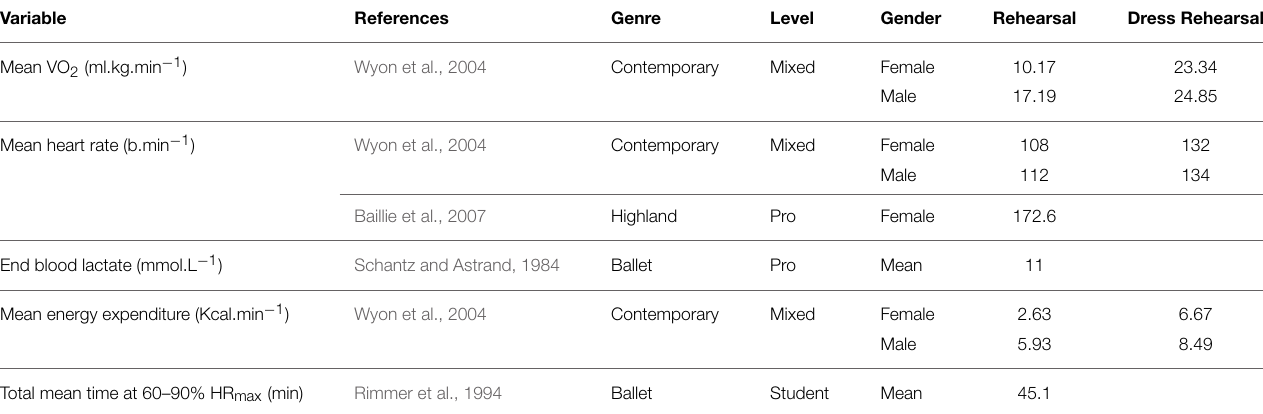
TABLE 3 | Mean data of studies examining the demand of dance rehearsal.